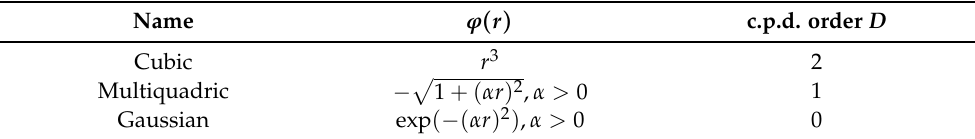
Table 1. Some radial functions ϕ : R ≥ 0 → R that are c.p.d. of order D ≤ 2, cf. [34].